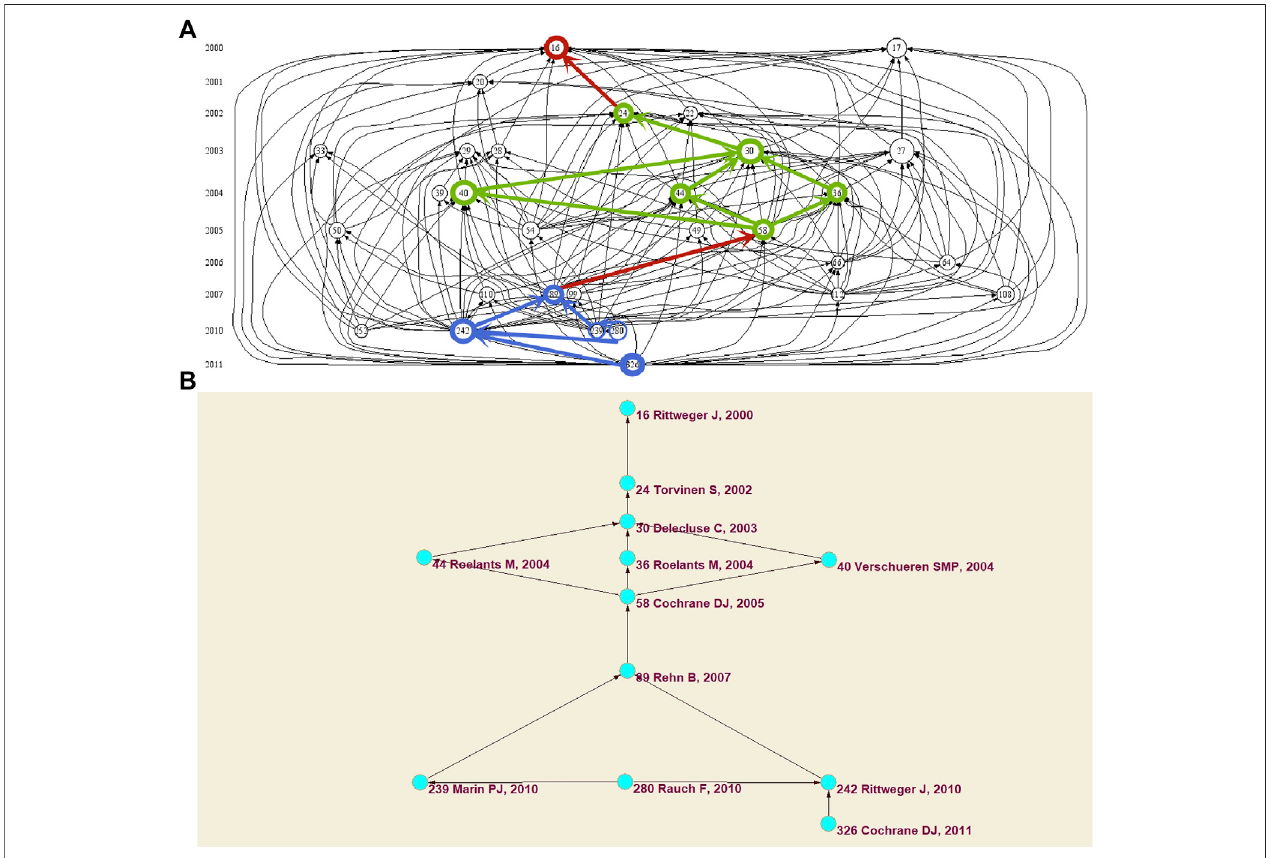
FIGURE 6 | Evolution and the main path analysis of WBVT. (A) Citation chronology fusion map of the main path; (B) Main path of the citation chronology map.